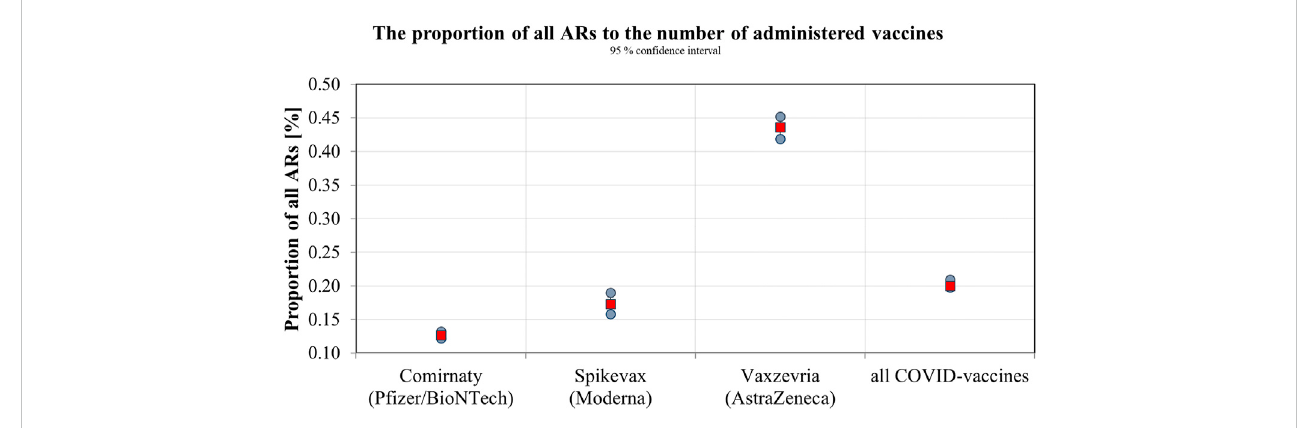
The proportion of all ARs to the number of administered vaccines.